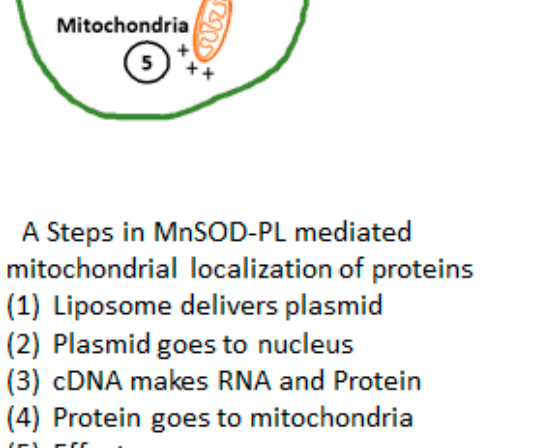
Figure 1. Transgene expression of plasmid/liposome complex or small molecules for radioprotection or radiomitigation. ( A ) shows the steps involved in expression of MnSOD from MnSOD-PL for radioprotection. ( B ) demonstrates the steps in the delivery of small molecule radiomitigator JP4-039 to the mitochondria.